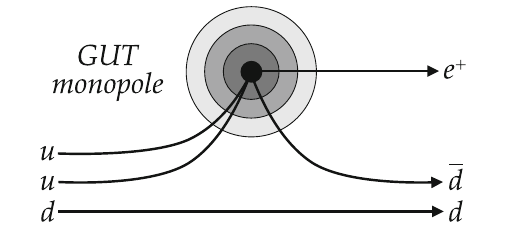
Fig. 34 Illustration of a proton decay into a positron and a neutral pion catalysed by a GUT monopole (after Ref. [328])